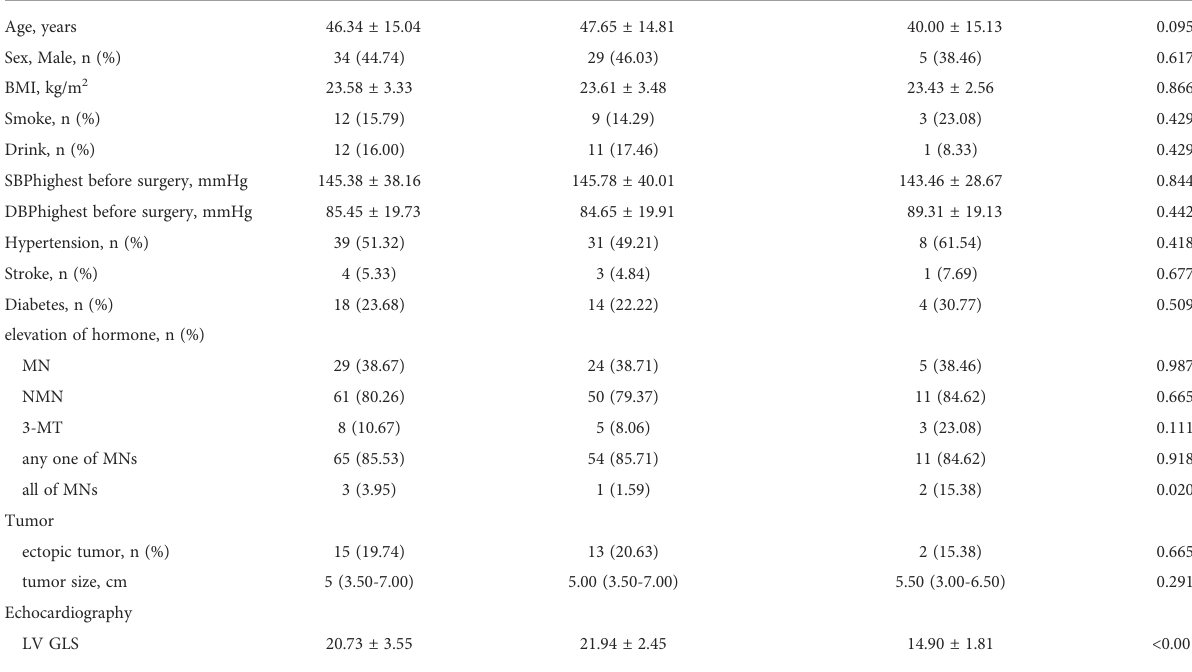
TABLE 1 Characteristics of all PCGL